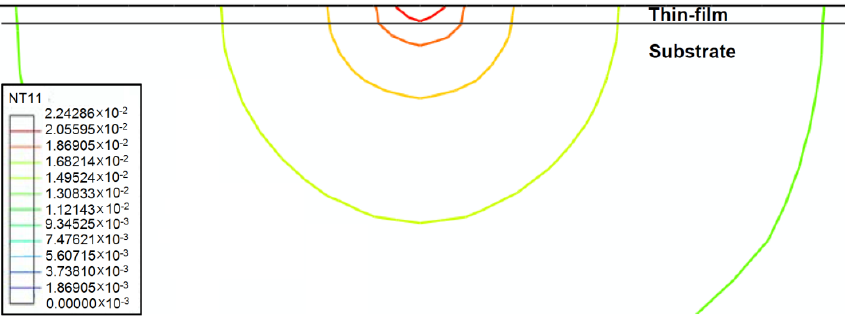
Figure 8. A typical cylindrical temperature increase (°C) contour profile of the AlN thin-film/Si substrate system. The thickness of the thin film is 2 μm.